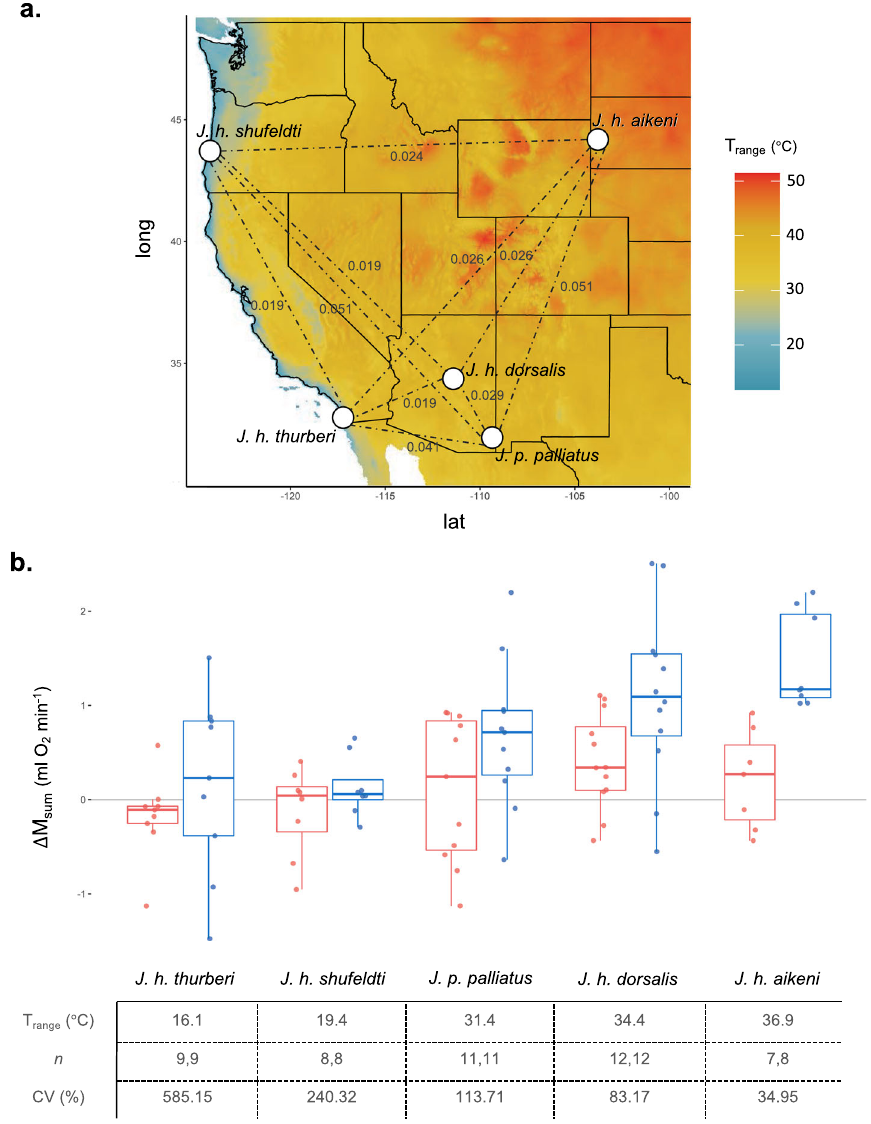
Fig. 3 Junco thermogenic fl exibility correlates with thermal heterogeneity. a Origin of fi ve Junco populations used in laboratory acclimations (dots) that differ in their native annual temperature range ( T range ; values from WorldClim 66 ), shown in shaded colors and plotted in R with package raster 67 . Pairwise F ST indicated by dotted lines and accompanying values in gray. b Thermogenic fl exibility, measured as the change in M sum over the 3-week temperature acclimation treatment (post- minus pre-acclimation), for each population. Boxplots show the median values, the 25th and 75th percentiles (lower and upper margins of the box), and the minimum and maximum values ≤ 1.5 × IQR from the box margin (whiskers). Dots indicate individual measures ( n = 95). Control birds (acclimated to 23 °C) in red; cold-acclimated birds (3 °C) in blue. For each population, the native T range , number of individuals in each treatment (Control, Cold), and coef fi cient of variation for cold-acclimated individuals (CV) are shown below. Source data are provided in the Source Data fi